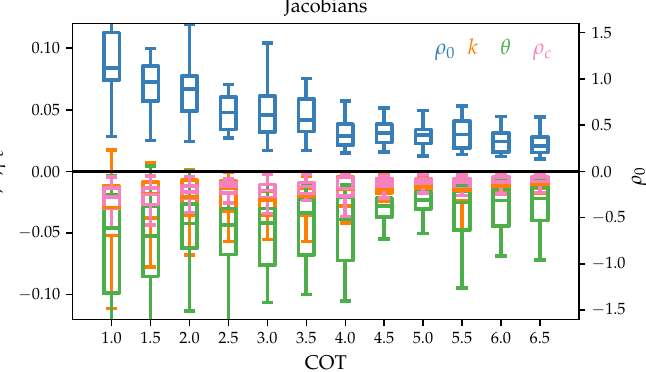
Figure 7. Magnitude of the Jacobian associated with each parameter of the Rahman–Pinty–Verstraete (RPV) surface model in function of the CISAR-retrieved COT. Given the different order of magnitude among the Jacobians, two scales are here used to better visualize the Jacobian dependency on the COT. The right y-axis is related to the ρ 0 , associated with the surface reflectance magnitude; the left y-axis is related to k (representing the bell or bowl shape of the surface anisotropy), θ (describing the presence of forward or backward scattering), and ρ c (associated with the hot spot effect), associated with the surface reflectance